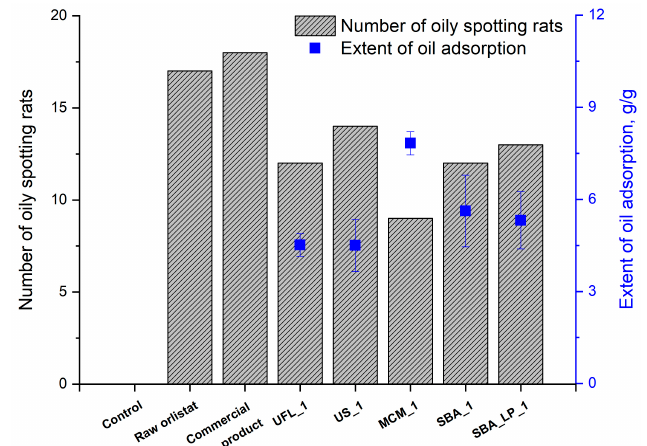
Figure 11. Number of rats showing oily spotting after administration of raw orlistat, the commercial product (Xenical ® ), and orlistat-loaded mesoporous silica (n = 26).